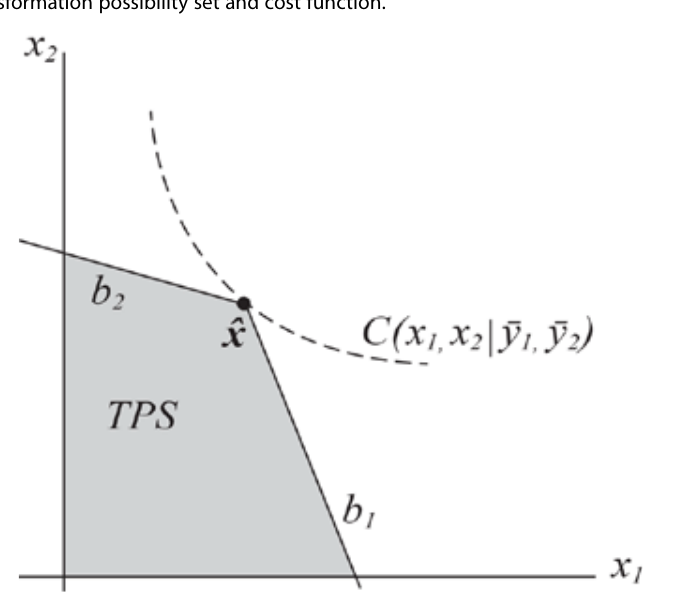
Figure 1. Transformation possibility set and cost